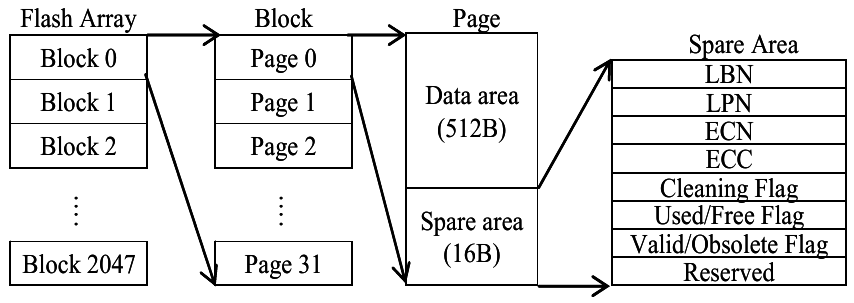
Figure 2. Flash memory (32 MB) architecture.